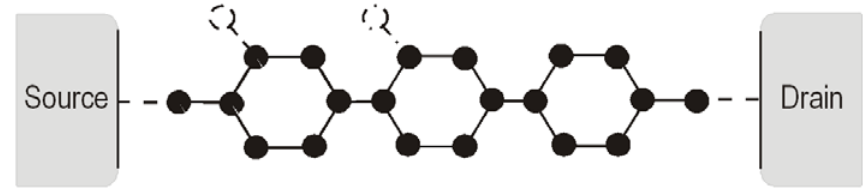
Fig. 4 Schematic representation of an analyzed sample (white circles denote positions of substituent